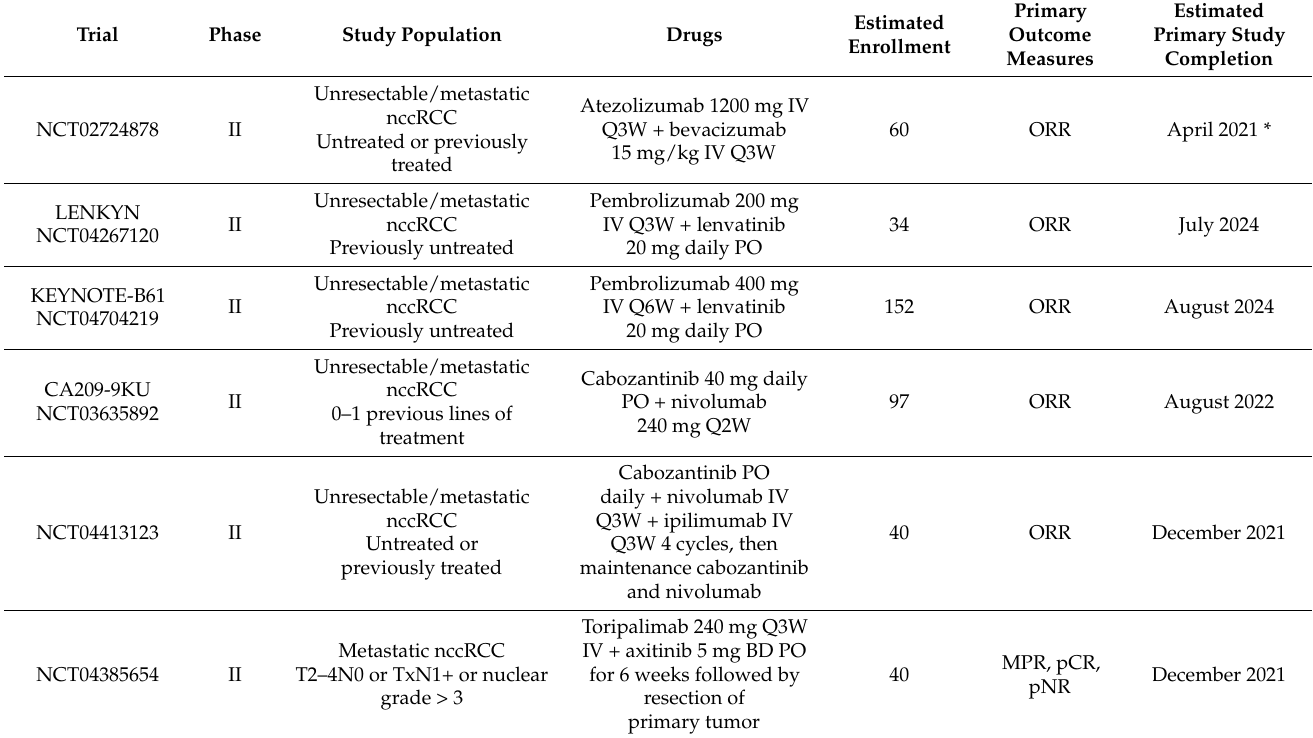
Table 2. Current combination immune checkpoint inhibitor and anti-angiogenic therapy trials in non-clear-cell renal cell carcinoma, as obtained from